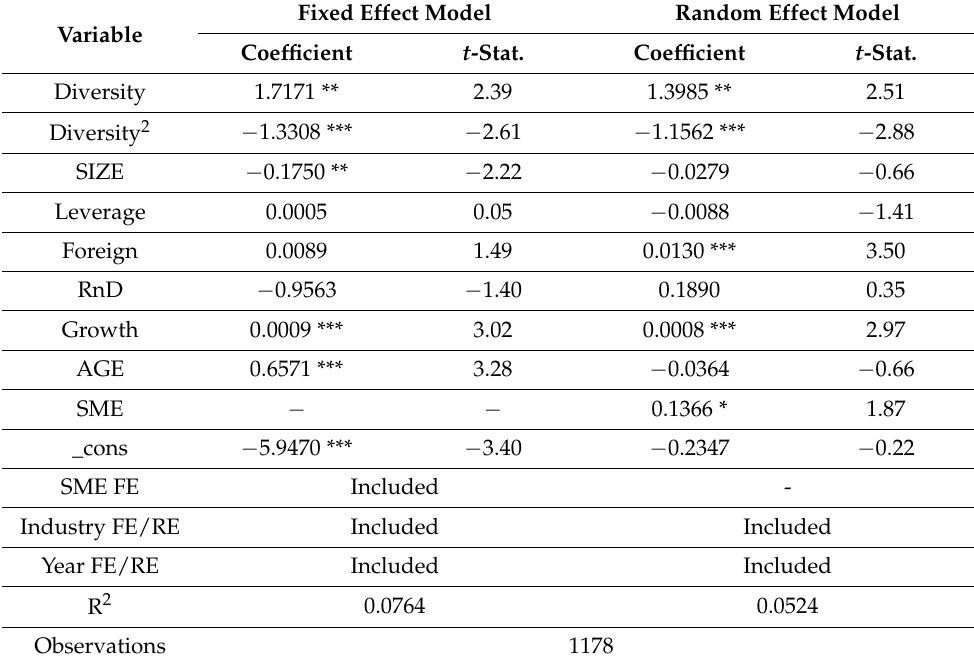
Table 4. Fixed and Random Effect Model Regression